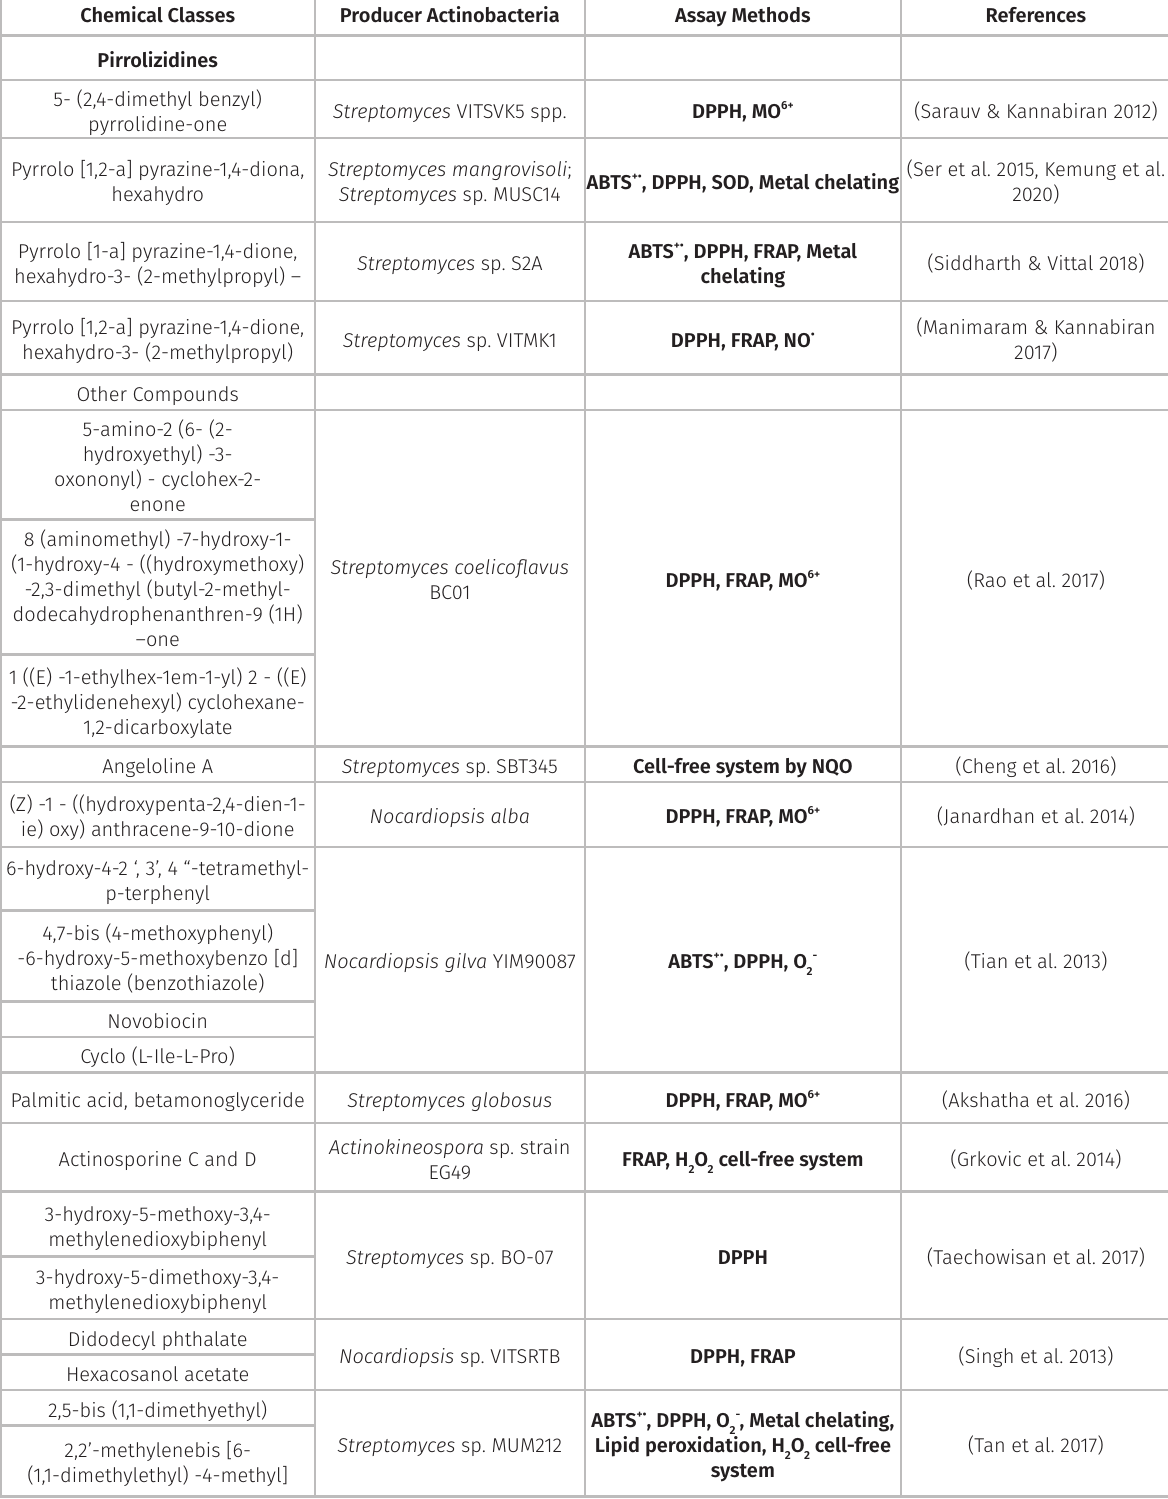
Table III. Iminosugars and other antioxidant compounds produced by Actinobacteria. Chemical